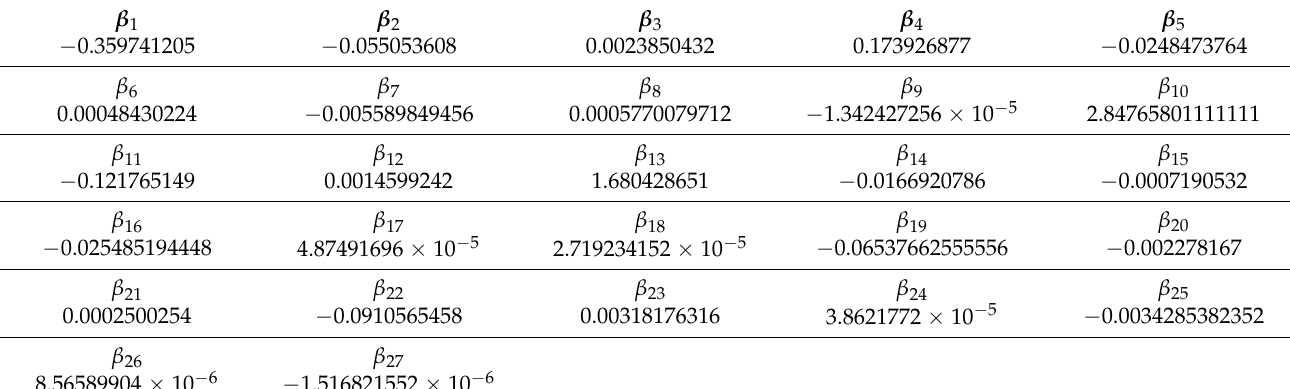
Table 2. Cooling tower model